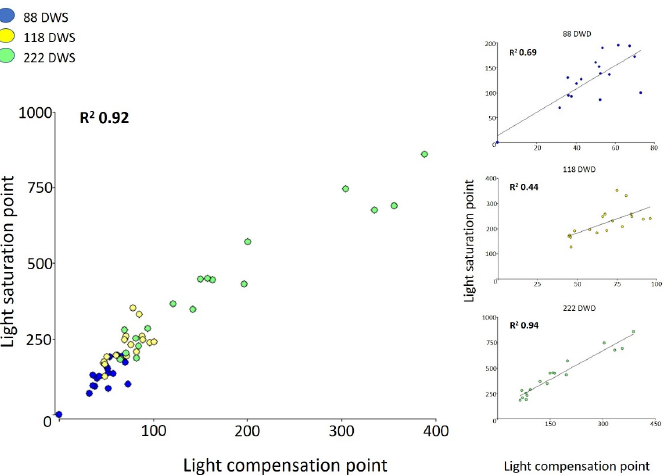
Figure A1. Linear regression between Light compensation and saturation points (large plot of the left). Small plots of the right show the linear regression between light compensation and saturation points within a specific day of water deprivation (i.e., 88, 118, and 222 DWD).